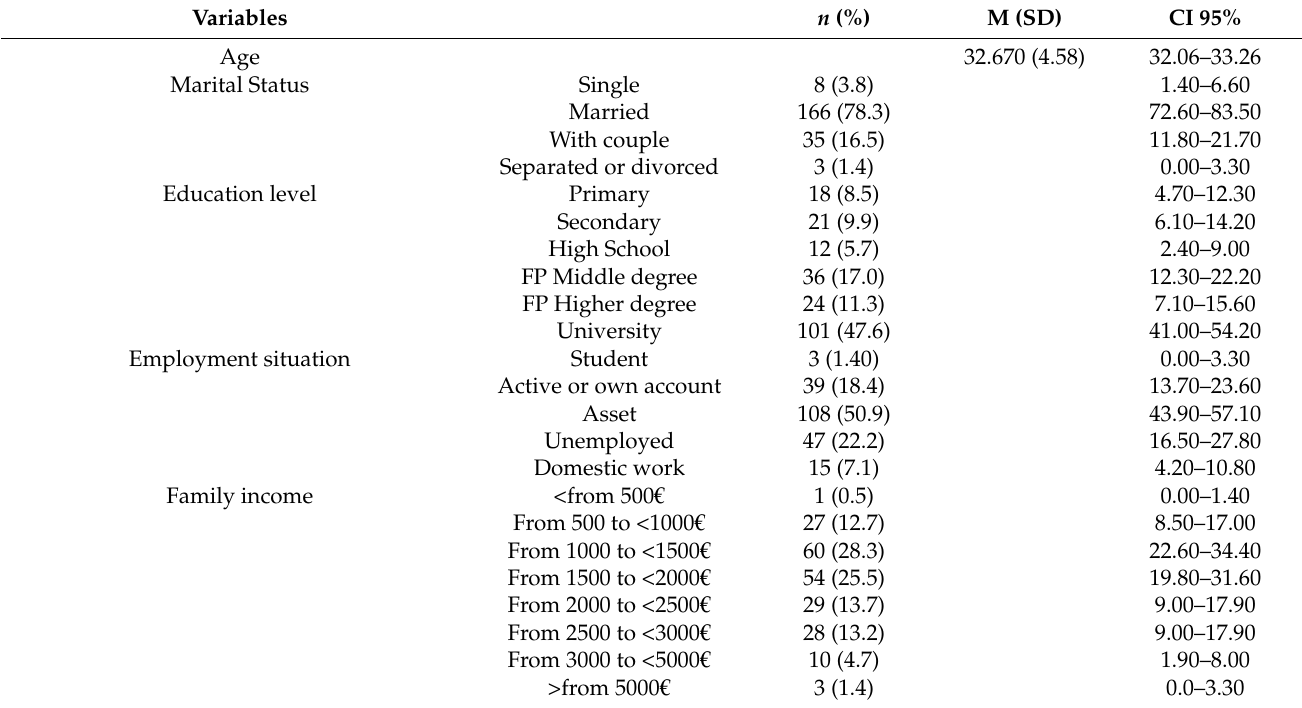
Table 1. Description of the studied